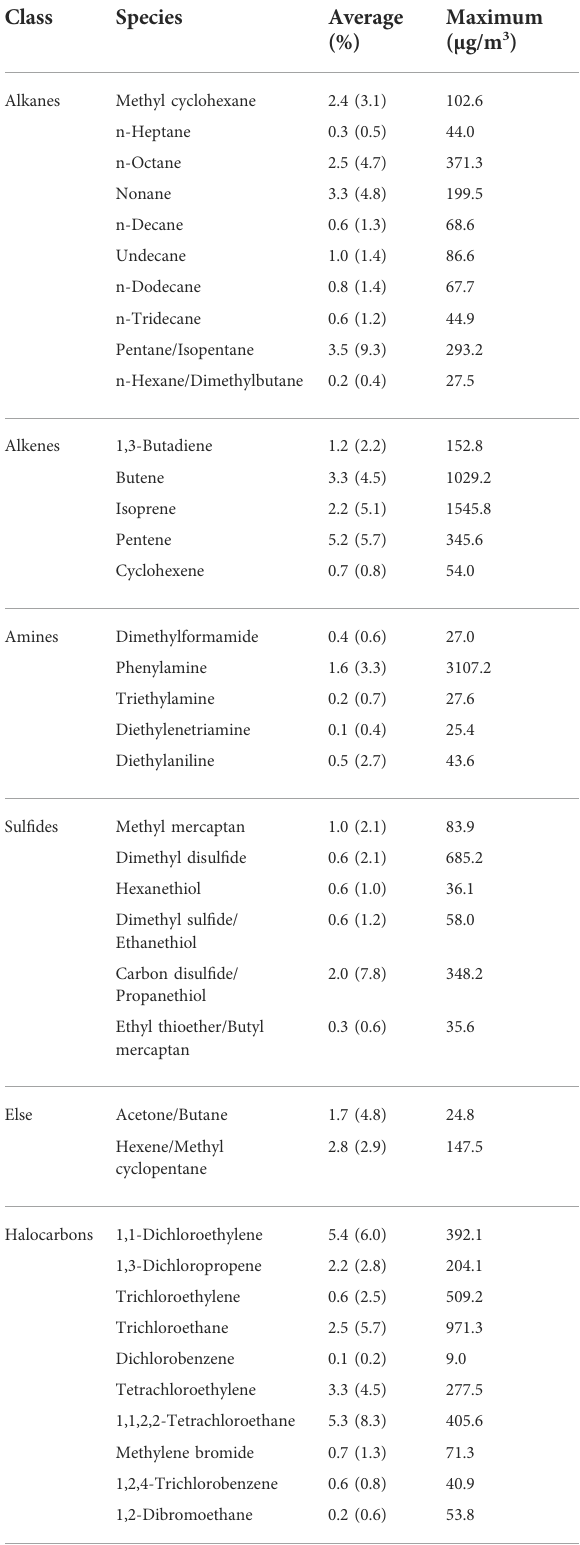
TABLE 2 Summary of VOCs concentration from cruise monitoring in Jilin Province.